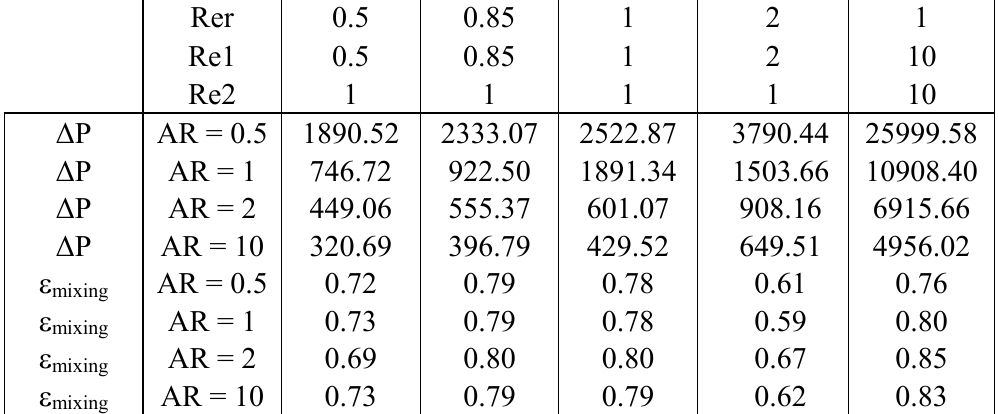
Table 2. Variations of mixing coefficient ( ε the Reynolds number ratio (Rer) and Aspect ratio (AR).